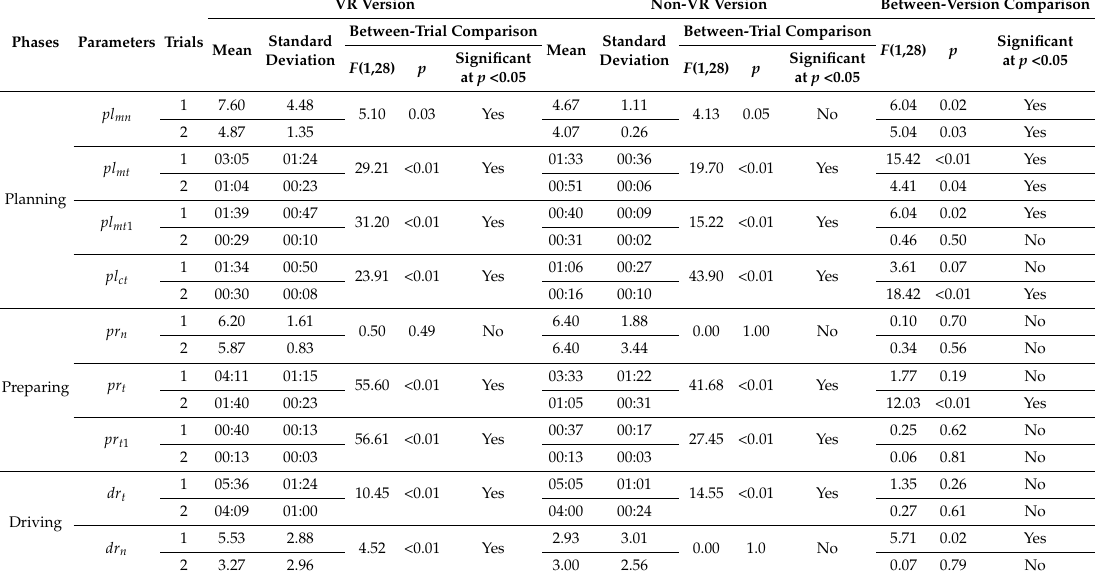
Table 4. Analysis results of user